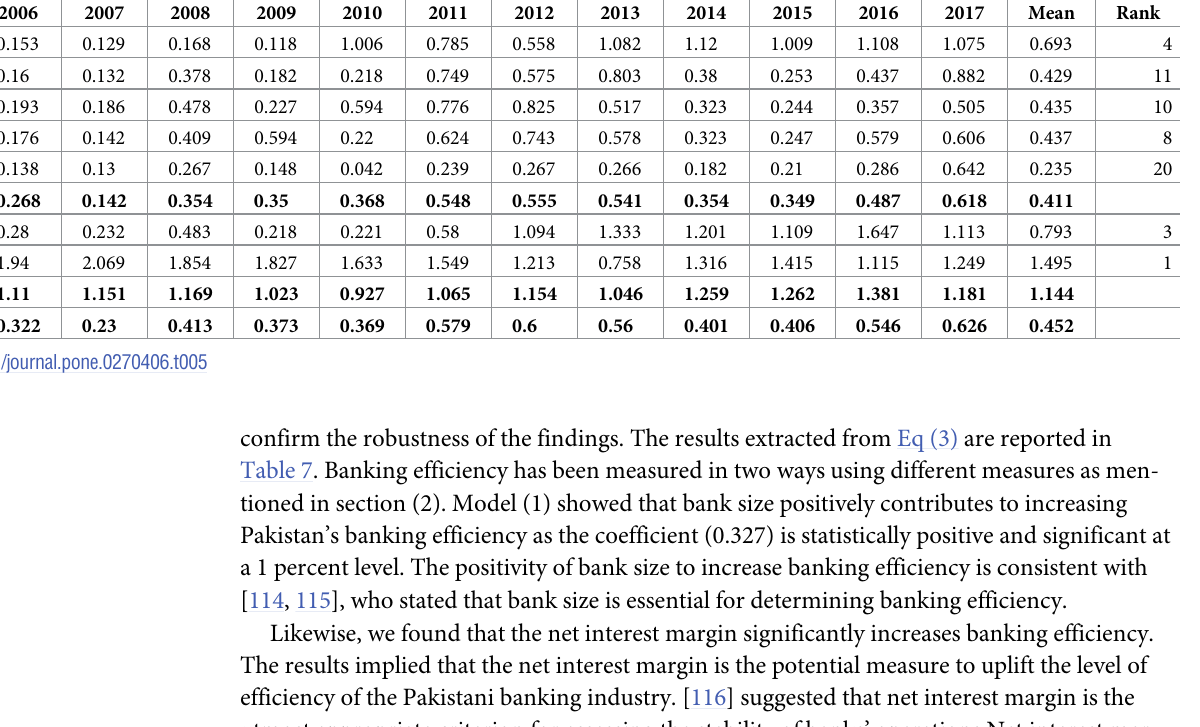
PLOS ONE | https://doi.org/10.1371/journal.pone.0270406 July 12,